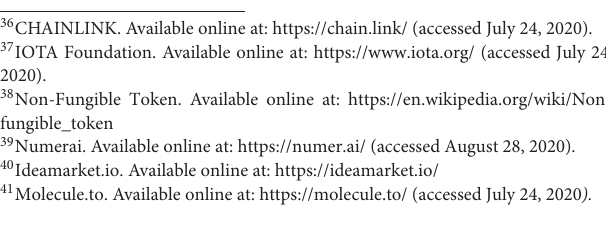
and “Internet of Things (IoT)” sensor networks 36,37 .